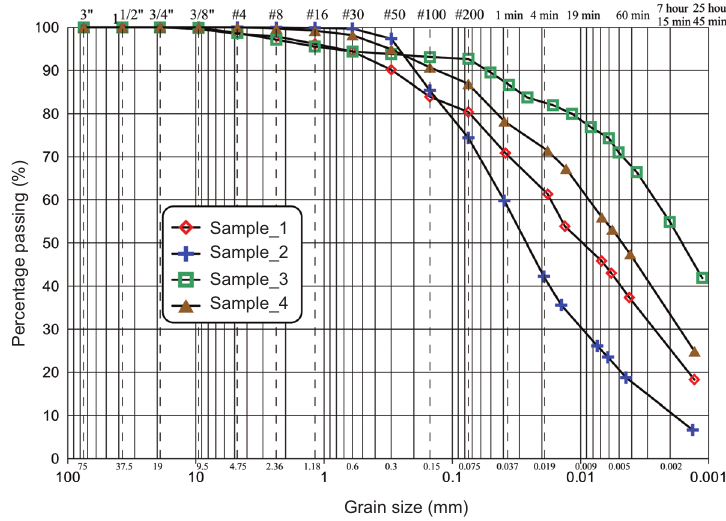
Figure 1 Grain-size distributions of the soil samples.